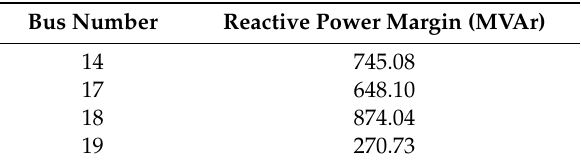
Table 3. Reactive power margin of load